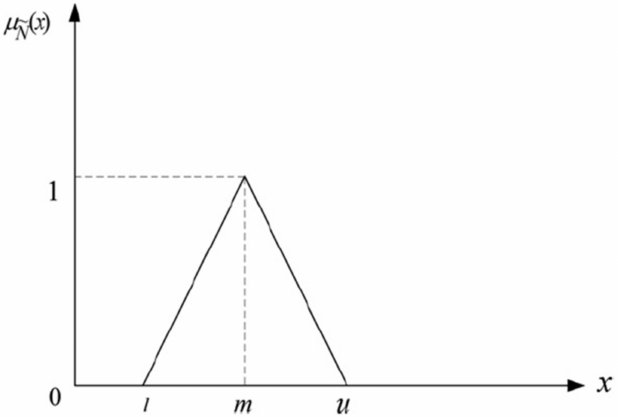
Figure 3. Triangular fuzzy